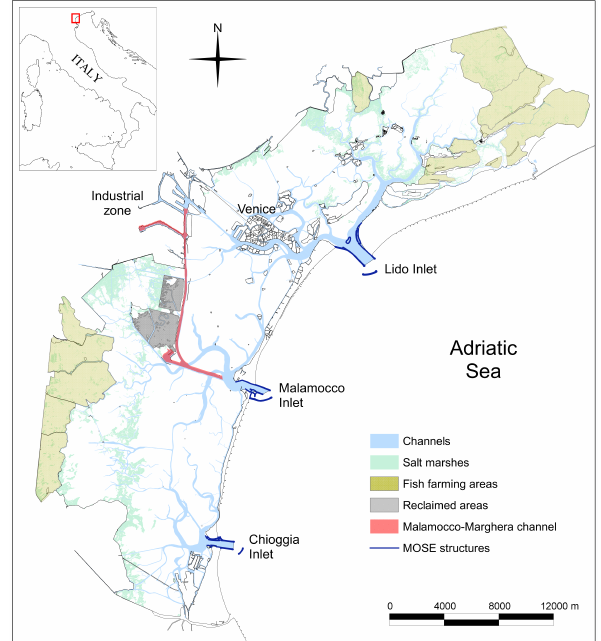
Fig. 1. The Lagoon of Venice in its present configuration (2012). Major morphological types (channels, salt marshes and fish farm- ing areas) and modifications (reclaimed area, Malamocco-Marghera channel and MoSE structures at the inlets) are